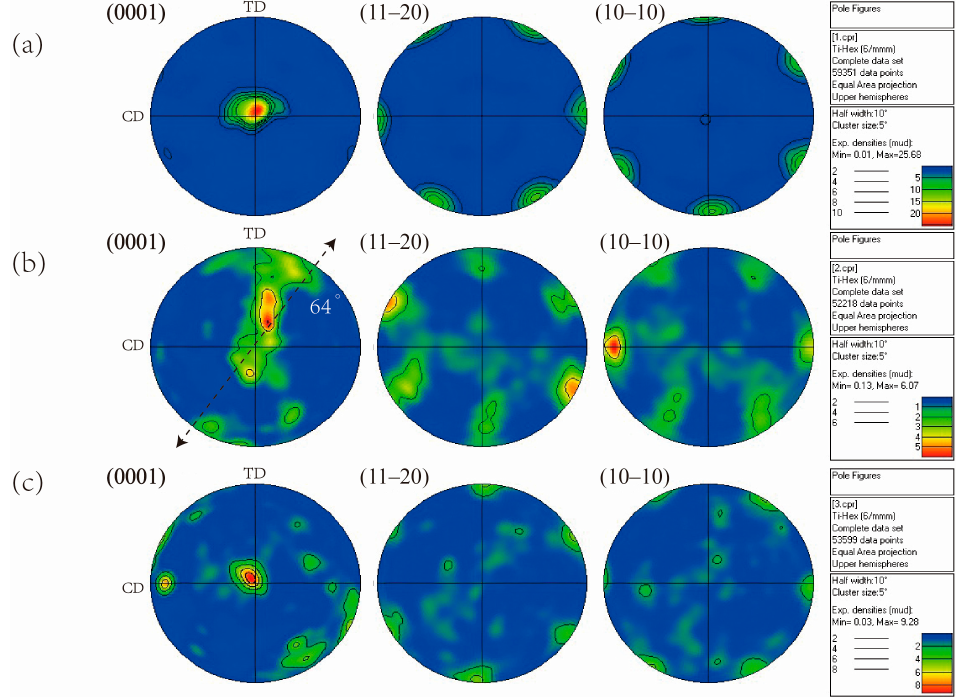
Figure 7. Pole figures of TC4 alloy after one cycle of MDIF: ( a ) one pass; ( b ) two passes; ( c ) three passes.